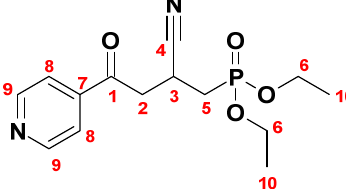
Figure 8. The structure of compound 5h .